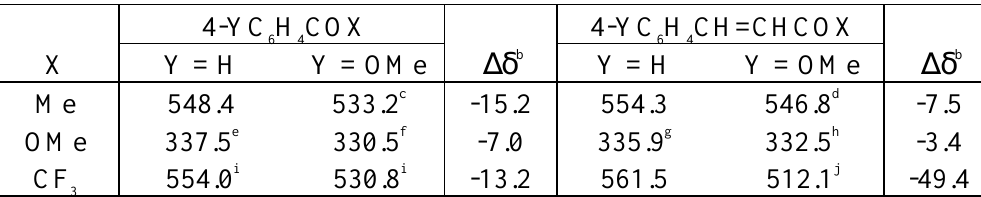
H CH=CHCOX (solvent 6 4